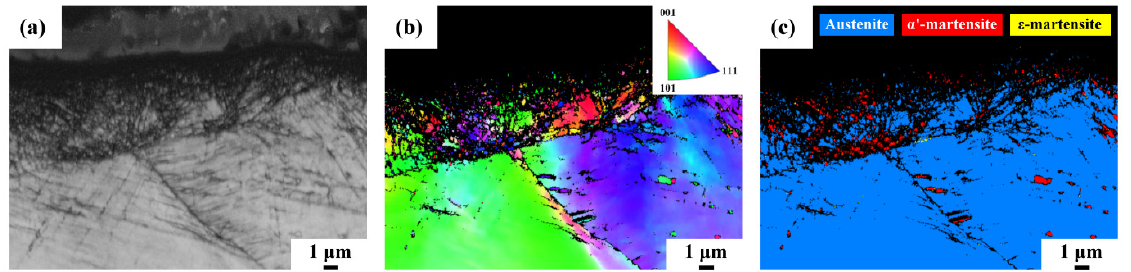
Figure 7. ( a ) Scanning electron micrograph, ( b ) the corresponding inverse pole figure (IPF) map and ( c ) the EBSD phase map of the shot-peened sample in cross-sectional view.